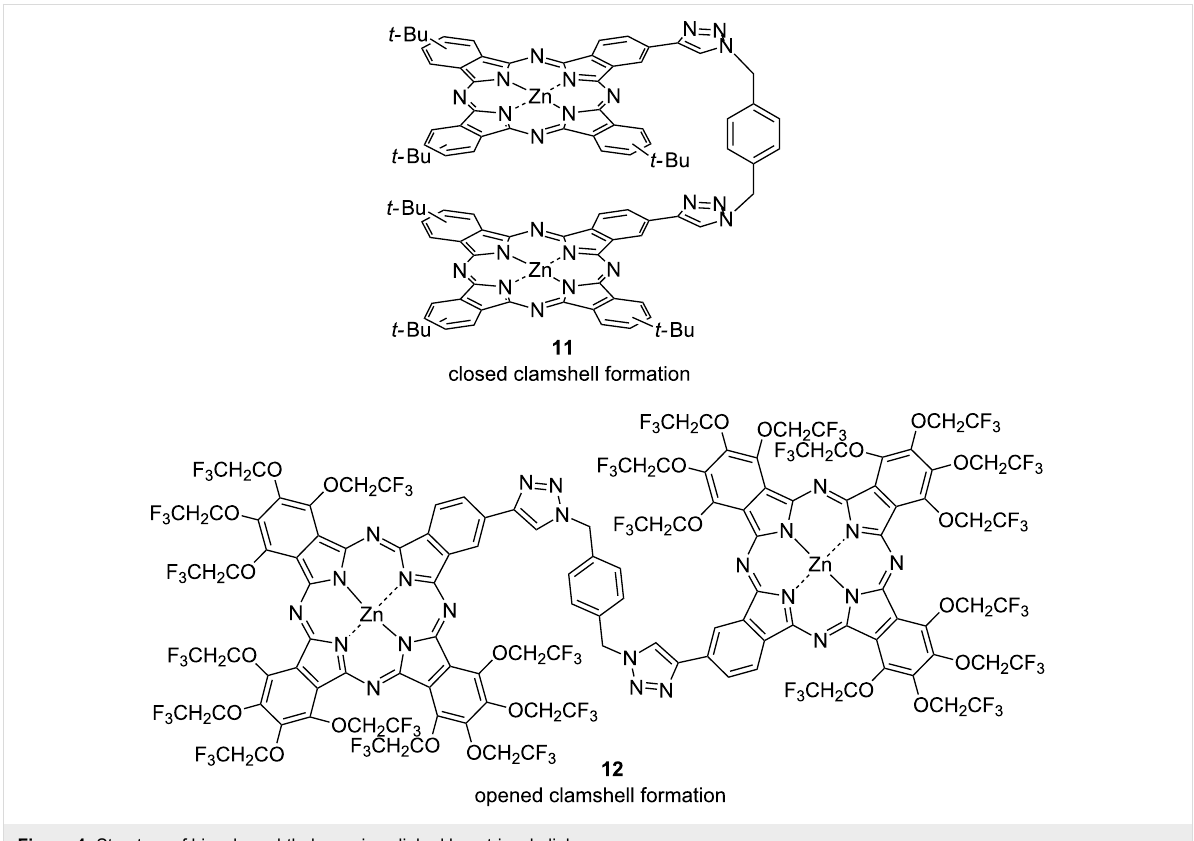
Figure 4: Structure of binuclear phthalocyanines linked by a triazole linker.